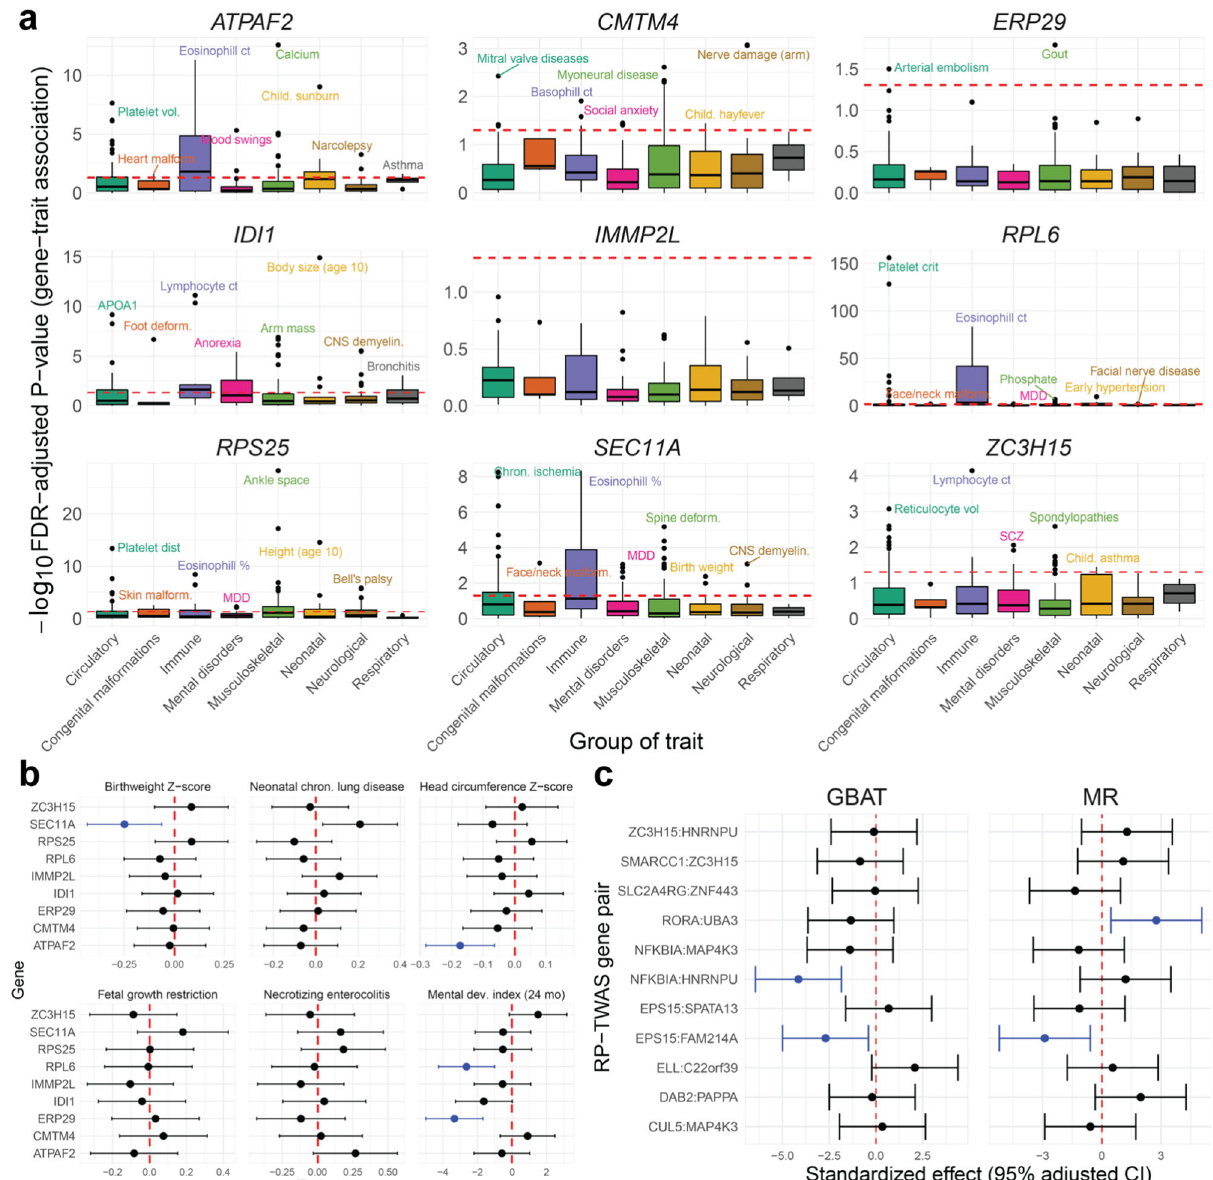
Fig. 5 Computational follow-up analyses of TWAS-prioritized genes. a Box-plot of -log10 FDR-adjusted P -value (two-sided weighted burden Z -tests) of multi-trait scans of GTAs in UKBB, grouped by eight groups of traits (grouped generally around ICD code blocks or organ systems) across nine genes with multiple TWAS GTAs across different trait categories. The red dotted line represents FDR-adjusted P = 0.05. Sample sizes vary for each trait. Boxplots provide, in order of bottom to top, the lower extreme, lower quartile, median, upper quartile, and upper extreme. b Forest plot of GTA association estimates (shown as points) and 95% FDR-adjusted two-sided Wald-type con fi dence intervals for six neonatal traits in ELGAN for nine genes with multiple TWAS GTAs across categories. The red line shows a null effect size of 0, and associations are colored blue for associations at FDR-adjusted P < 0.05. Sample size of 729 individuals from ELGAN were used to derived these estimates. c Follow - up GBAT and Mendelian randomization (MR) analysis results using RICHS data. On the left, effect size (shown as points) and 95% adjusted con fi dence intervals from GBAT ( x -axis; two-sided t -test, df = 148) between GReX of RP- encoding genes and TWAS gene associations (pairs given on y -axis). On the right, MR effect size and 95% adjusted con fi dence interval ( x -axis; two-sided Wald-type test) of RP-gene on TWAS gene (pairs on y -axis). The red line shows a null effect size of 0, and associations are colored blue for associations at FDR-adjusted p < 0.05. Sample size of 149 individuals from RICHS were used to derive these